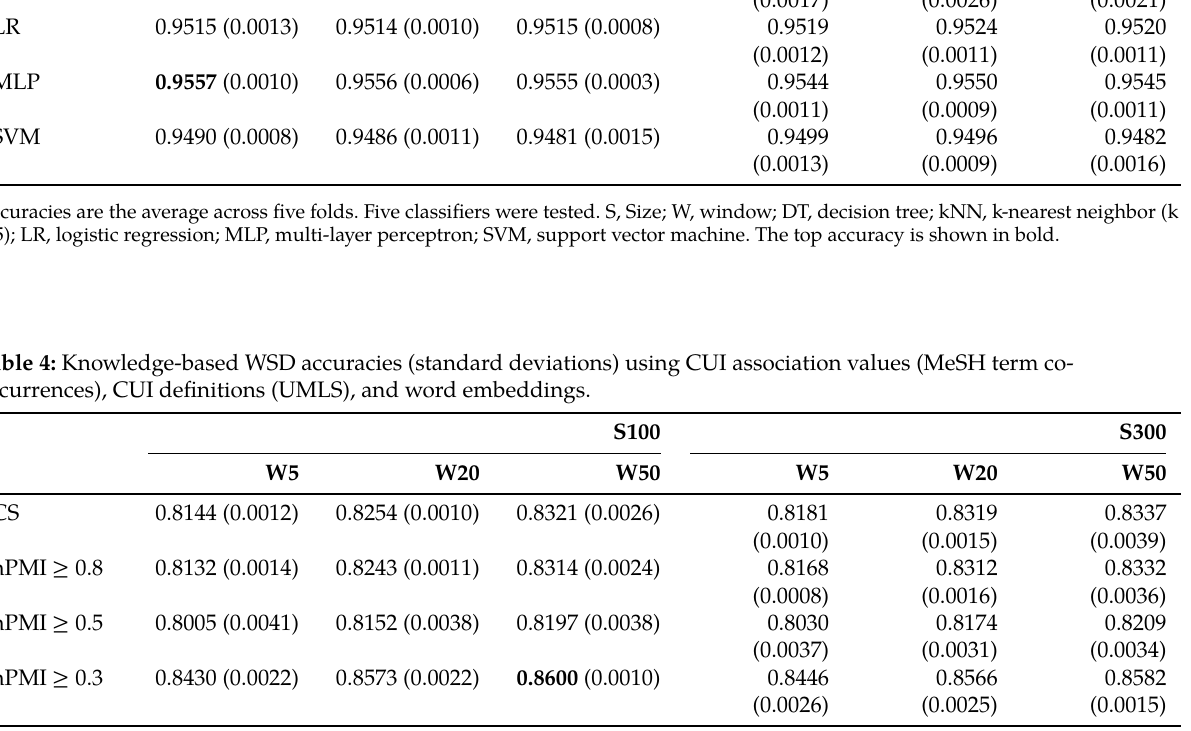
Table 5: Knowledge-based WSD accuracies (standard deviations) using CUI association values (MeSH term co- occurrences), CUI definitions (UMLS), and word embeddings.